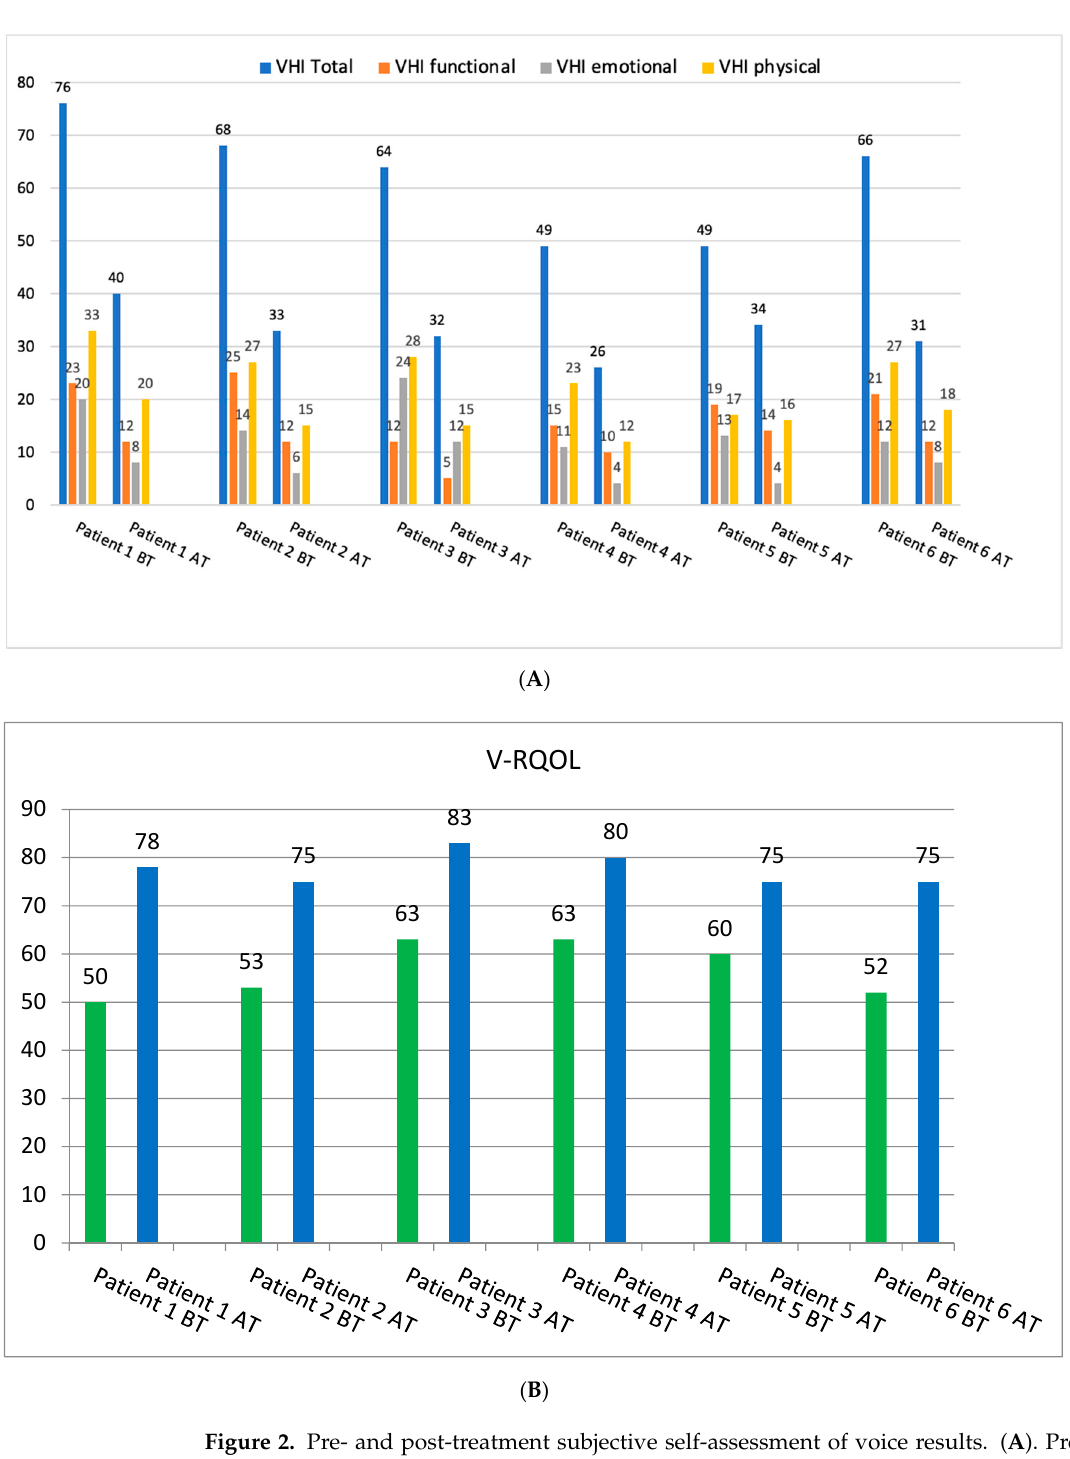
Figure 2. Pre- and post-treatment subjective self-assessment of voice results. ( A ). Pre- and post- treatment scores for the VHI total and domains. ( B ). Pre- and post-treatment scores for the V-RQOL total. BT—before treatment; AT—after treatment.